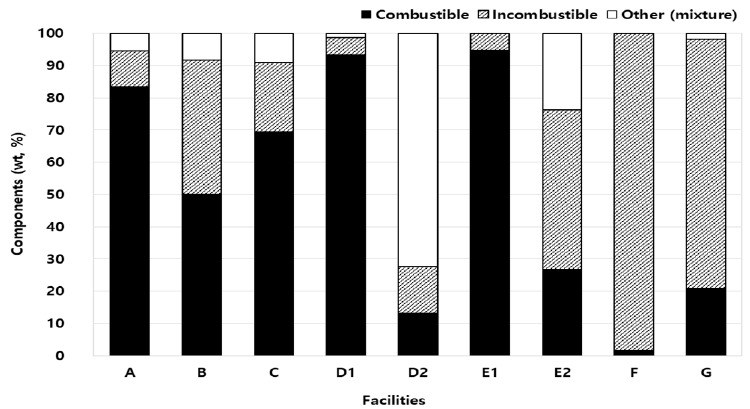
Figure 1. Physical composition of residues from SRF facilities.